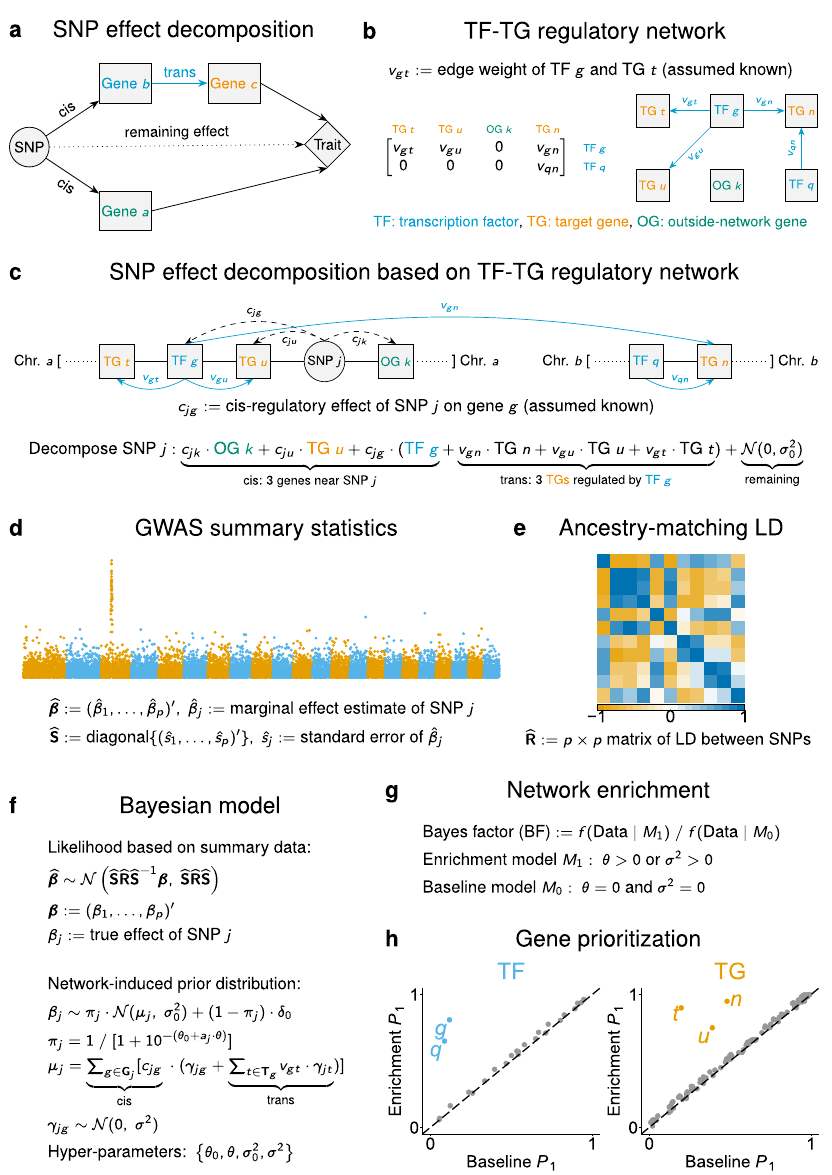
Fig. 1 Schematic of RSS-NET. a Decomposition of the total effect of a common SNP on a complex trait through multiple nearby and distal genes. b Gene regulatory network de fi ned as a weighted and directed bipartite graph linking TFs to TGs. c RSS-NET exploits the topology of a TF-TG network to decompose the total genetic effect into cis and trans-regulatory components. Both the SNP-gene ( c jg ) and TF-TG ( v gt ) weights in this decomposition are assumed known and are speci fi ed by existing omics data (Methods). In addition to TF-TG networks, RSS-NET also requires d GWAS summary statistics and e ancestry-matching LD estimates as input. f Bayesian hierarchical model underlying RSS-NET. An in-depth description is provided in Methods. g Given a network, RSS-NET produces a Bayes factor comparing the baseline ( M 0 ) and enrichment ( M 1 ) models to summarize the evidence for network enrichment. h RSS-NET prioritizes loci within an enriched network by computing P 1 , the posterior probability that at least one SNP j in a locus is trait- associated ( β j ≠ 0). Differences between P 1 under M 0 and M 1 re fl ect the in fl uence of a regulatory network on genetic associations, highlighting previously undescribed trait-associated